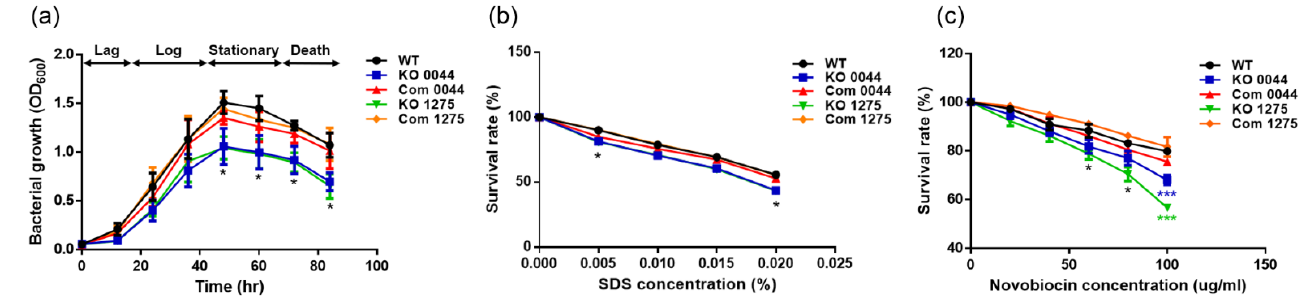
Figure 4. Effects of the HP0044- and HP1275 -disrupted mutations on H. pylori growth, sensitivity to the detergent SDS and resistance to the antibiotic novobiocin. ( a ) The growth curves of wild- type strain 26695, the HP0044 and HP1275 knockout mutants and their corresponding knockout complementary mutants. The data were recorded by a spectrophotometer at OD 600 at different time points. The data are presented as the average OD 600 values derived from triplicate trials with statistical analysis (unpaired, two-tailed Student’s t -test; * p < 0.05). ( b ) SDS sensitivity and ( c ) novobiocin resistance of the tested H. pylori strains. The effects of the HP0044 and HP1275 mutations on SDS sensitivity and novobiocin resistance of H. pylori were evaluated by the survival rate, which was measured by the ratio of the OD 600 of bacteria incubated with/without various concentrations of SDS and novobiocin. The data presented were derived from triplicate trials with statistical analysis (unpaired, two-tailed Student’s t -test; * p < 0.05 and *** p < 0.001). WT, wild-type strain; KO, knockout mutant; and Com, knockout complementary